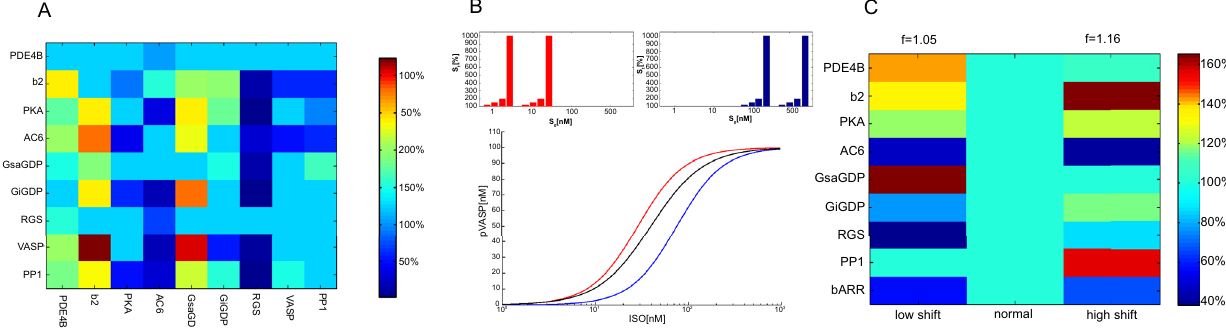
Figure 4. A . Concentration changes in response to total protein concentration reduction. Selected concentrations were reduced to 10% (shown on the x-axis). Learning was applied until f values were improved (shown on top for each experiment). Colors show the relative adjustment of all concentrations on the y-axis. B . Transfer function response to shifts in input signal range (shown on top). C . Concentrations changes in response to extracellular signal shift. Matrix is constructed as in A